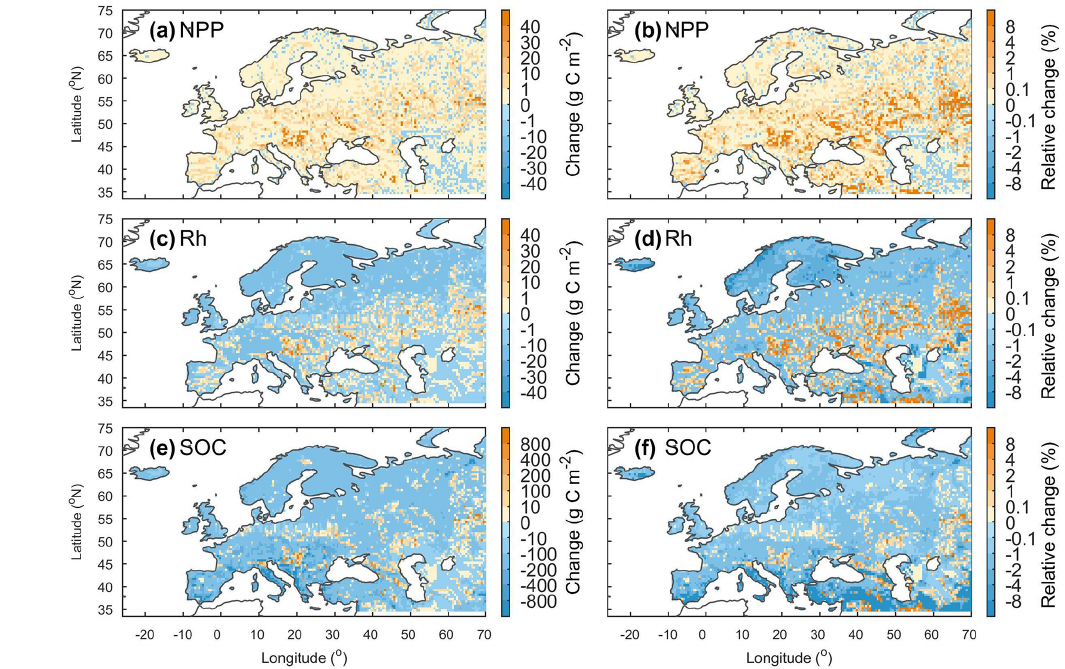
Figure 12. Changes (first column) and relative changes (second column) in the net primary production (NPP), heterotrophic respiration (Rh), and total soil organic carbon (SOC, 0–2m) in Europe due to lateral carbon transport during 1901–2014. For each variable, the change is calculated as C lat − C nolat , where C lat and C nolat are the carbon fluxes or stocks when lateral carbon transport is considered and ignored, respectively. The relative changes is calculated as ( C lat − C nolat ) /C nolat ×